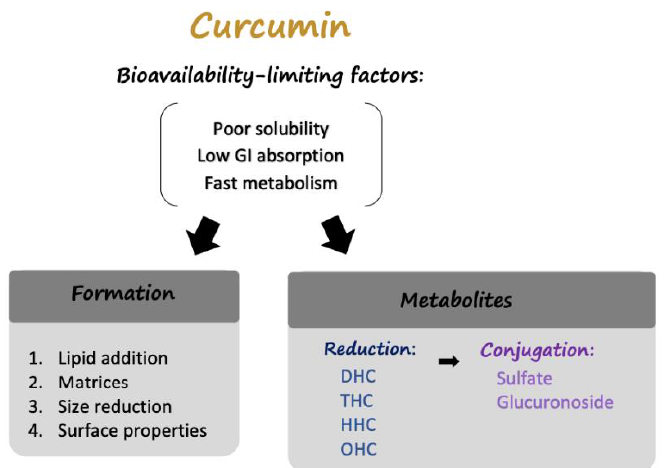
Figure 1. The factors limiting curcumin bioavailability and solutions. Poor solubility, low gastroin- testinal absorption, and fast hepatic and intestinal metabolism are the main factors that constrain curcumin utilization by the human body. Studies on the delivery of curcumin in different formula- tions and metabolites of curcumin have been conducted to address these factors. Four strategies to sion on matrices, size reduction, and alterations to surface properties. Regarding the metabolites of